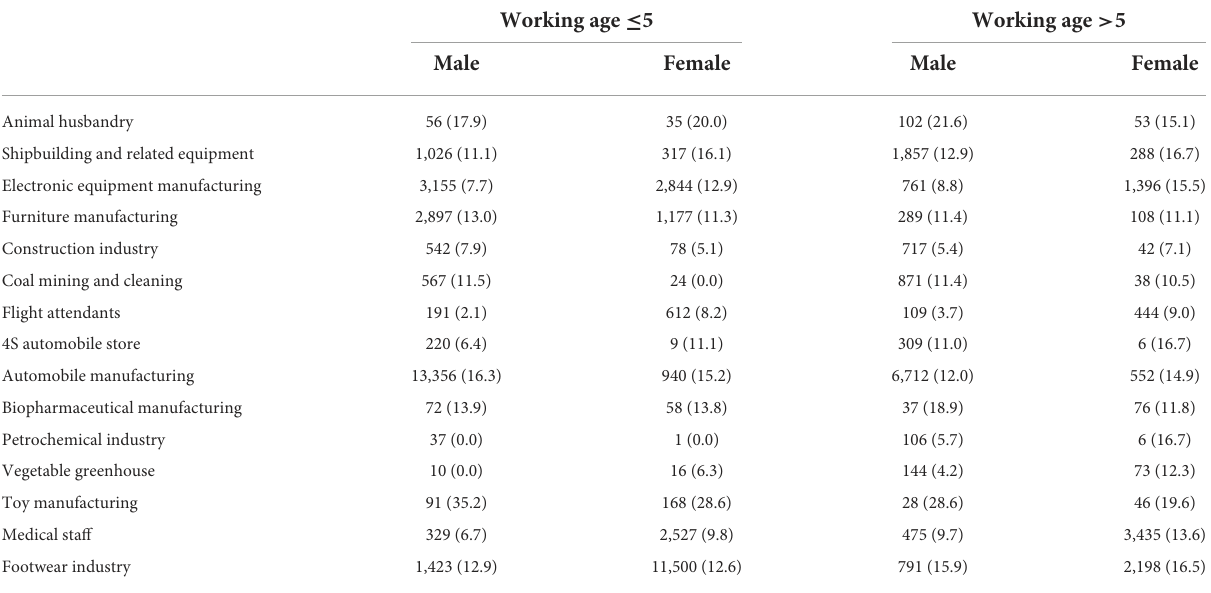
TABLE 3 Prevalence of wrist injuries by industry by age of service and